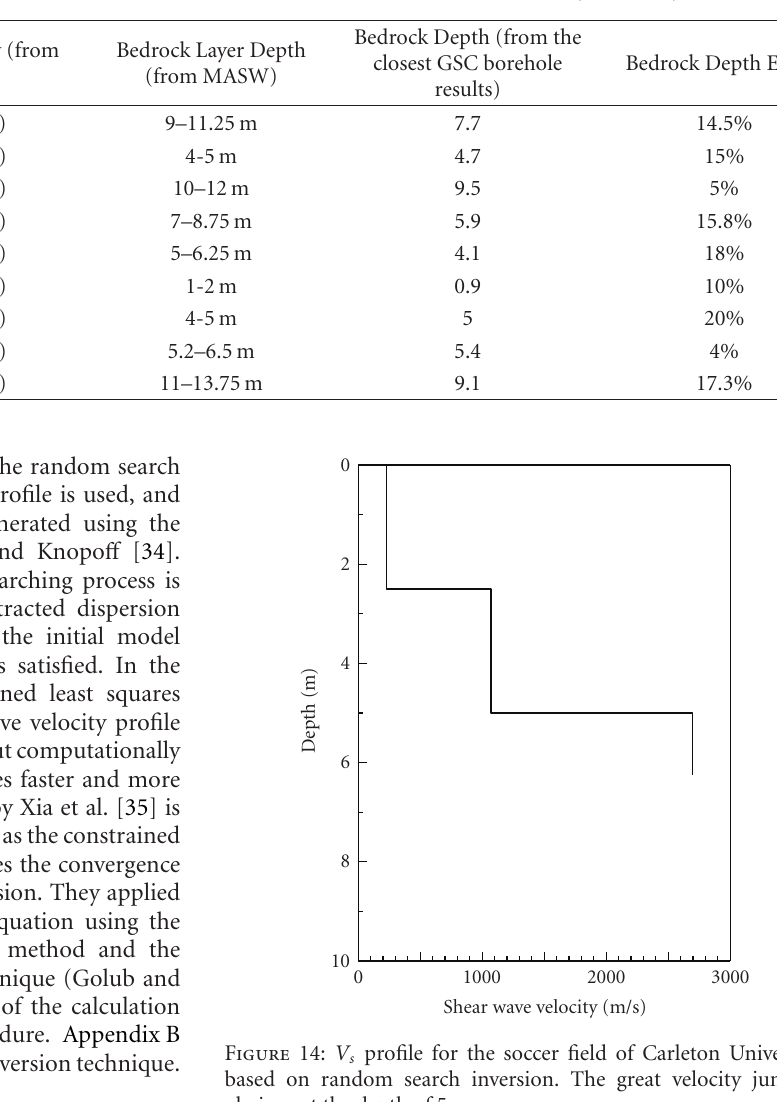
Table 3: Comparison between estimated MASW results and borehole data for shallow bedrock (canal sites).